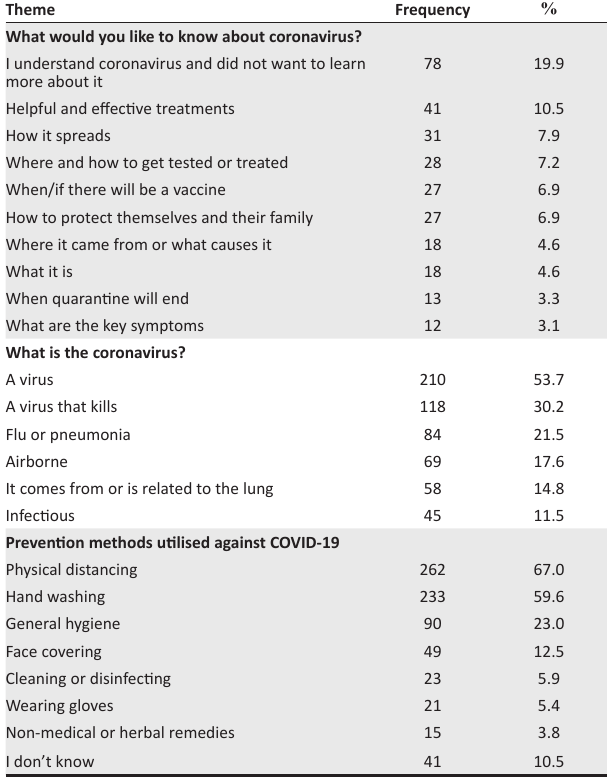
TABLE 2: Knowledge and perception of